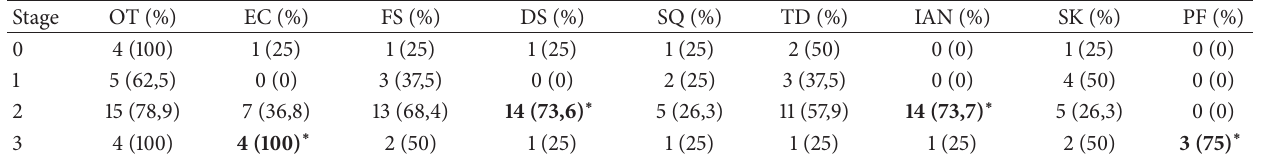
Table 3: Number and percentage of radiographic findings in each